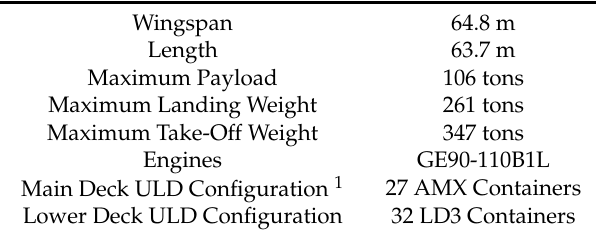
Table 3. Key specifications of the AeroLogic Boeing B777-200LRF